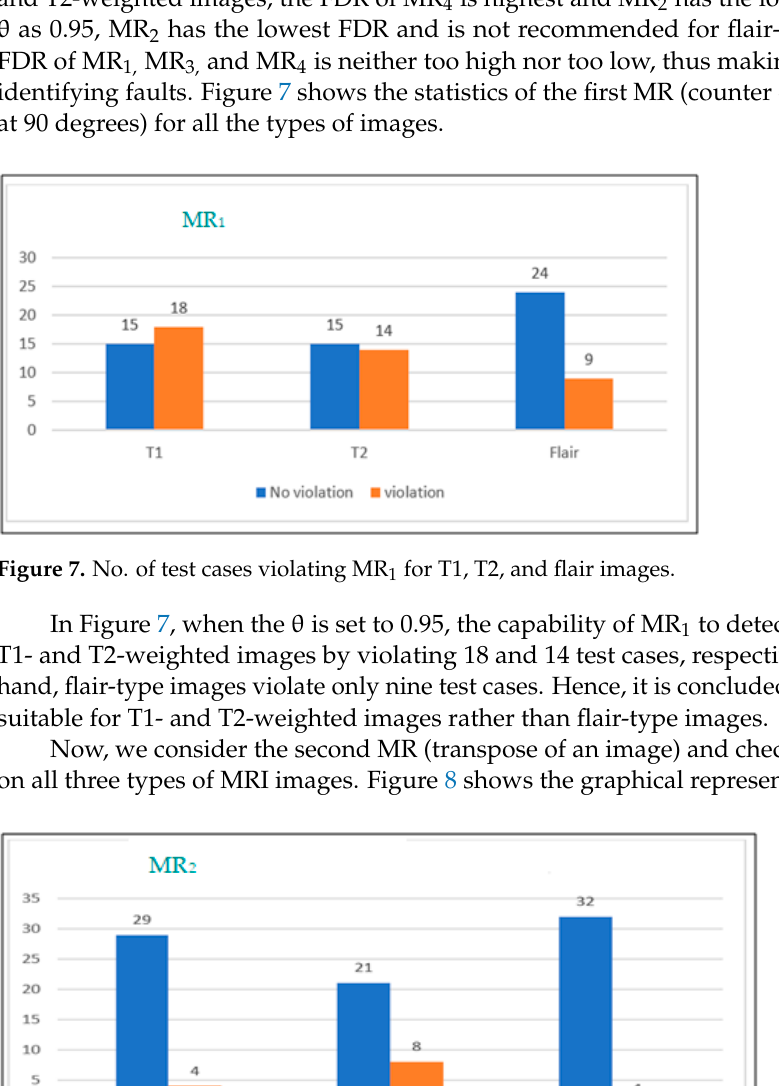
Figure 9. No. of test cases violating MR 3 for T1, T2, and flair image. Figure 9 shows that the capability of MR 3 to detect faults is low for flair-type images by violating only 8 test cases, whereas the capability of MR 3 to detect faults is high for T1- and T2-weighted images by violating 12 and 13 test cases, respectively. It is concluded that MR 3 is recommended for all the categories of images. The fault detection capability of this MR is low for flair-type images when comparing with T1- and T2-weighted im- ages, but it is still able to detect faults. The last MR is reflection at abscissa. Figure 10 shows the statistics of MR 4 .